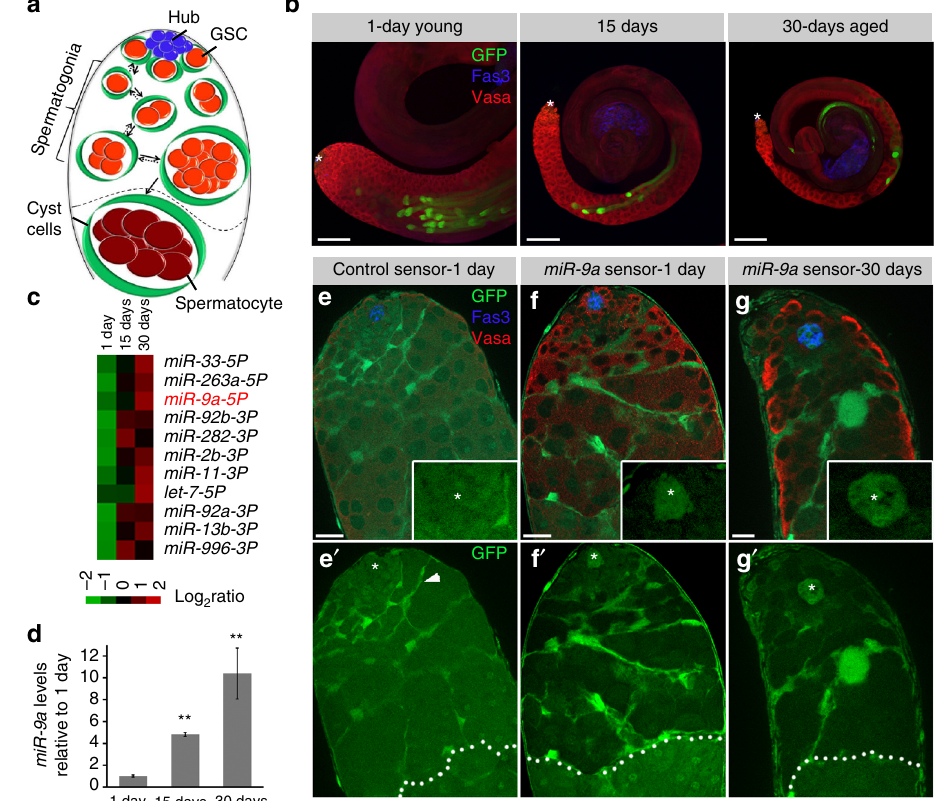
Fig. 1 miR-9a increases during ageing and is expressed in GSCs and spermatogonia. a Side-view representation of the apical tip of the Drosophila testis. GSCs ( red ) are anchored to the hub ( blue ) and spermatogonia germ cells ( red ) can terminally differentiate to spermatocytes ( crimson ) or dedifferentiate to GSCs ( two-directional arrows ). GSCs and spermatogonia are encapsulated by cyst cells ( green ). Dashed-line separates spermatogonia from spermatocytes. b Testes from 1-day, 15-days, or 30-days-old males ( green , mature sperms; Imp CB04573 ) immunostained for Vasa ( red , germ cells) and Fas3 ( blue , hub and seminal vesicles). Note an age-related decrease in cell numbers and in overall testis size. Scale bars , 100 µ m. Asterisks mark the hub. c Heatmap of fold- change of Drosophila miRNAs in testes of 1-day, 15-days, or 30-days-old wild-type ( w 1118 ) fl ies. Top 11 most age-altered miRNAs out of a total of 100 are shown. DESeq de fi ned signi fi cance between 30-days and 1-day for each miRNA ( P adj < 0.05; n = 2 replicas for each time point). d qRT-PCR for mature miR- 9a relative to control ( 2S rRNA ) in the testes of 1-day, 15-days, or 30-days-old wild-type ( w 1118 ) males. Levels are normalized to 1-day-old adults. Error bars denote s.d. of three biological repeats each in triplicate measurements. Note a 10-fold increase of miR-9a in 30-days. Statistical signi fi cance was determined by one-way ANOVA and post hoc analysis was performed with Tukey multi-comparison test. ** P ≤ 0.005 between 15 and 1-day and between 30 and 1-day. e – g ’ Testes of control GFP sensor ( e , e ’ ) and miR-9a sensor 1-day ( f , f ’ ) and 30-days ( g , g ’ ) stained for Fas3 ( blue ) to mark the hub ( asterisks ), Vasa to mark the germ cells ( red ) and GFP ( green ). A control sensor is expressed in all cells at the apical tip of the testis including: hub, GSCs, CySCs, cyst cells ( arrowhead ), spermatogonia and spermatocytes. The miR-9a sensor detect endogenous levels of miR-9a in GSCs and spermatogonia. Dashed-line separates spermatogonia from spermatocytes. Note that miR-9a is not expressed in spermatocytes or the somatic niche (hub and cyst cells). All images in all fi gures are single sections. Scale bars , 10 µ